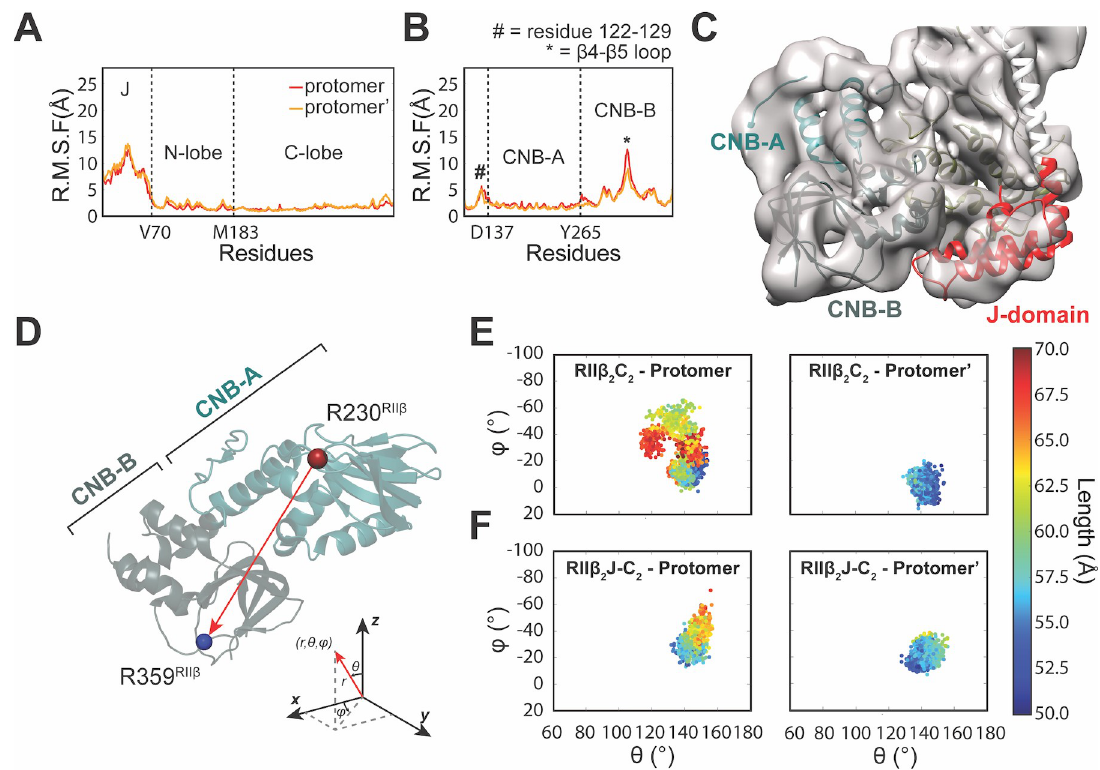
Fig 3. MD simulations of the RII β 2 J-C 2 holoenzyme reveal distinct dynamics. ( A ) Both N- and C-lobe of J-C subunit remain stable but J-domain is flexible in the RMSF analysis of the RII β 2 J-C 2 holoenzyme. ( B ) CNB-B domain of the RII β subunit in both protomers remain stable in the RMSF analysis in RII β 2 C 2 holoenzyme. ( C ) J-domain and CNB-B domain of the RII β 2 J-C 2 holoenzyme are in close proximity. ( D ) The representation of polar coordinate vector from Arg230 RII β to Arg359 RII β . ( E , F ) The plots of φ , θ , and length of the vectors from Arg230 RII β to Arg359 RII β in MD simulations of RII β 2 C 2 (E) and RII β 2 J-C 2 holoenzymes (F). The vector in one of the protomers of the RII β 2 C 2 holoenzyme moves and fluctuates significantly (E), whereas the vectors in both protomers of the RII β 2 J-C 2 holoenzyme remain stable (F). The data used to make these figures can be found in S1 Data. CNB, cyclic nucleotide binding; MD, molecular dynamics; RMSF, root-mean-square